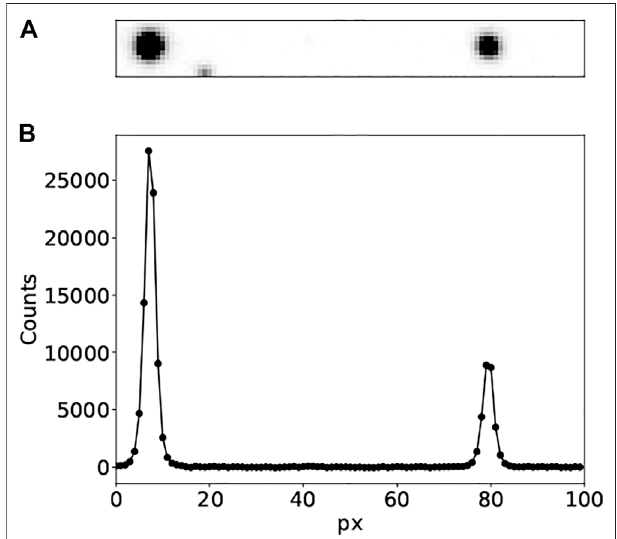
FIGURE 4 | Example with two stars in the image after reduction (A) and theirprojectionontooneaxis,whereeachpointcorrespondstothecountsina pixel (B)